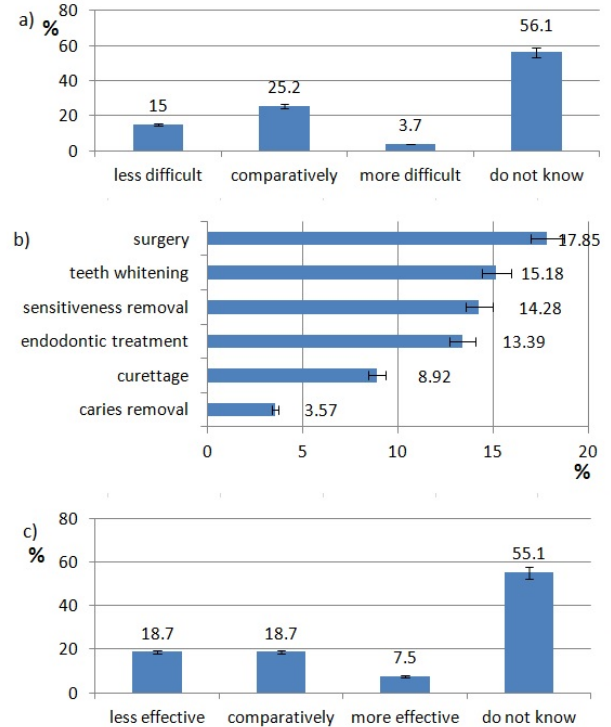
Figure 2. Laser use pattern of responding dentists. ( a ) difficulty of laser procedures, ( b ) type of laser procedures, ( c ) effectiveness of laser procedures.